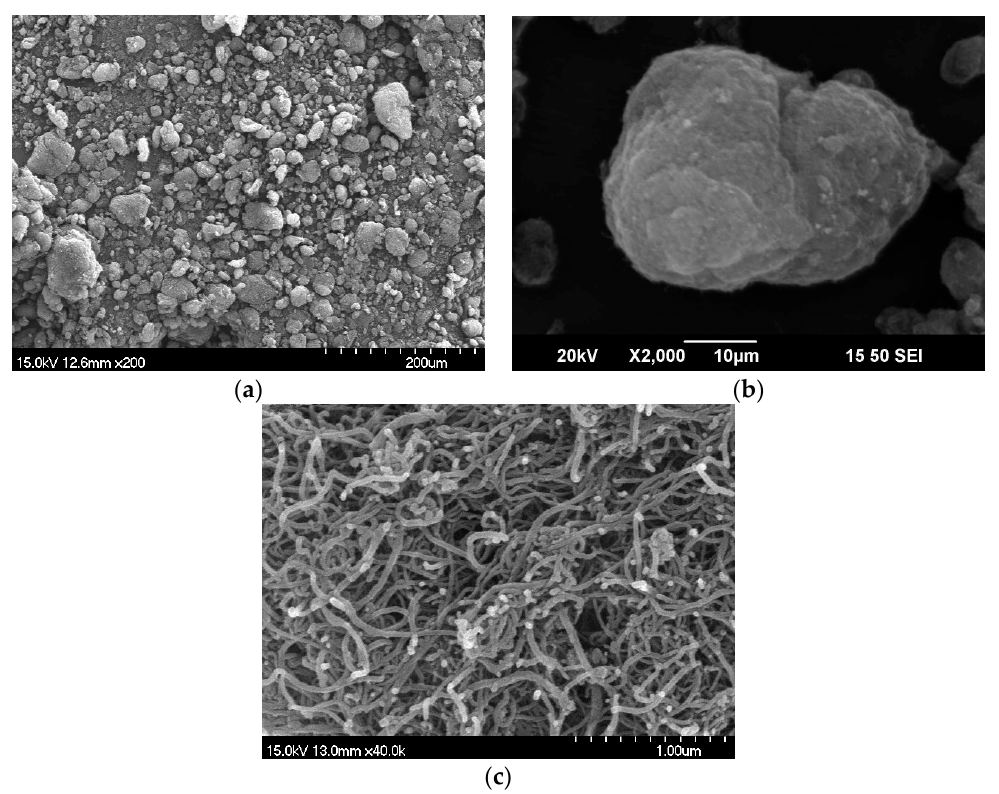
Figure 9. Microstructure of aligned MWCNTs under various scales by SEM: ( a ) scale 1:200; ( b ) scale 1:2000; ( c ) scale 1:40000.